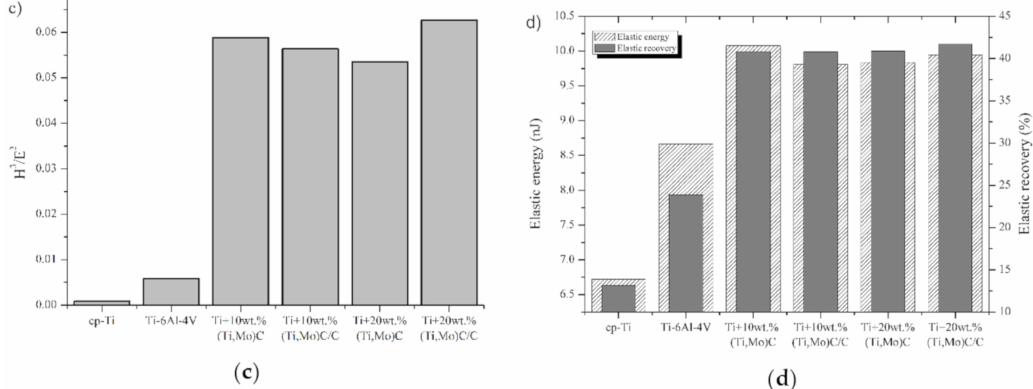
Figure 13. ( a ) H/E; ( b ) H 2 /E, ( c ) H 3 /E 2 ; ( d ) elastic energy and elastic recovery values of the composites with respect to reinforcing quantity of the carbides and reference specimens cp-Ti and Ti-6Al-4V.